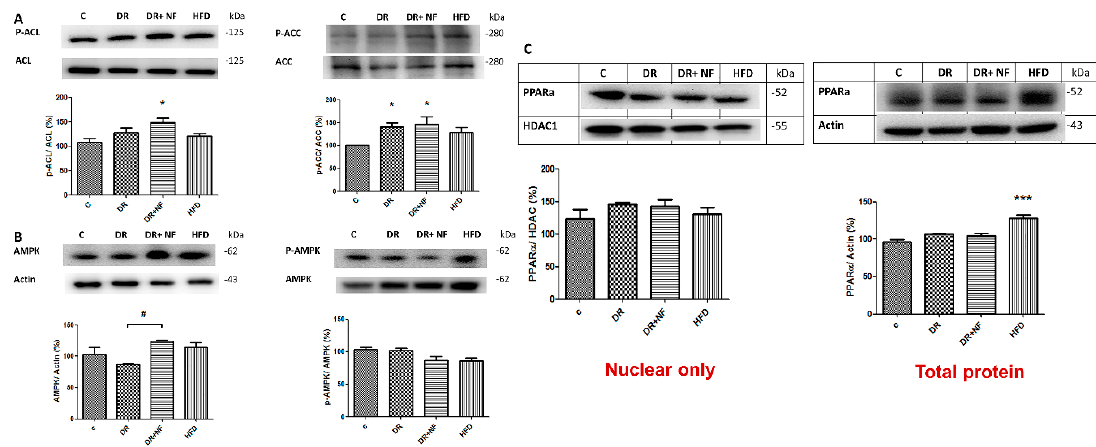
Figure 6. The western blot expression of 5 ′ Adenosine monophosphate-activated protein (AMPK) and peroxisome proliferator-activated receptor 1- α (PPAR- α ) in rats. ( n = 3) ( A ) In renal tissue, phospho-acetyl-CoA carboxylase (P-ACC)/ACC was increased in the DR and DR+NF groups (148% and 150%, respectively, * p < 0.05). ( B ) AMPK expression (actin as control) in the DR+NF group was increased relative to the DR group ( # p < 0.05), whereas phospho-AMPK/AMPK was decreased in DR+NF compared with the control group (# p < 0.05). ( C ) Nuclear PPAR- α protein expression levels were similar (HDAC as the internal control). However, total PPAR- α protein was increased by up to 130% in the HFD group compared to the control (actin as control) (*** p < 0.05).